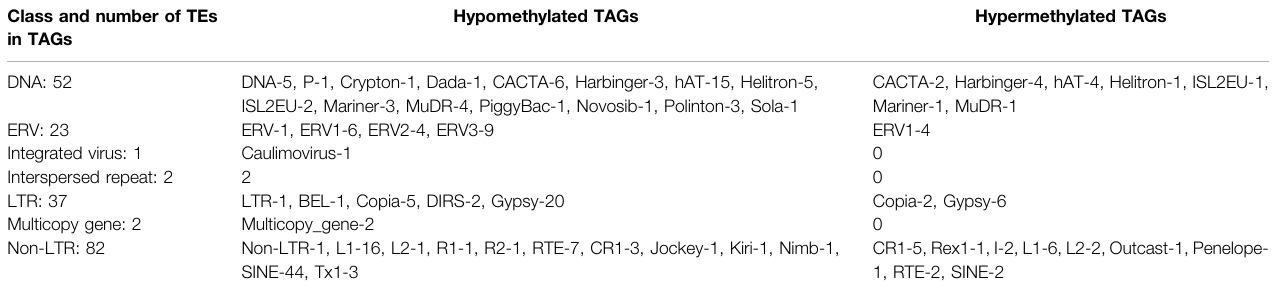
TABLE 4 | Hypomethylated and hypermethylated TAGs along with the frequencies of TE subclasses. Class and number of TEs in